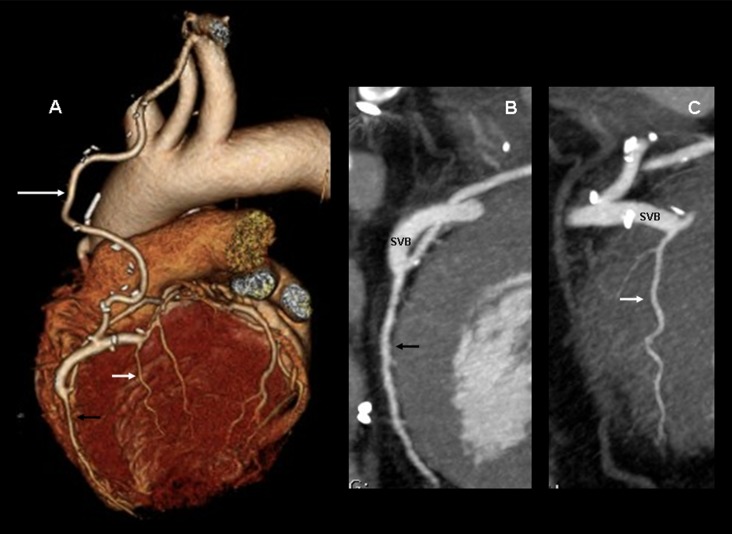
Composite coronary artery bypass graft.256-slice MDCT with prospective ECG-gating, volume rendering (A) and curve reformat (B, C) of a 56-yo man with a composite internal mammary artery with saphenous vein bridge graft (IMA-SVB). The IMA-SVB graft redistributes the flow of the IMA (long white arrow) to the left anterior descending artery (LAD) (black arrow) and to the first diagonal artery (D1) (short white arrow). Distal graft anastomoses on LAD and D1 are well seen. The scores for image quality in all graft segments were 5 (excellent), for both 2 independent observers. SVB: saphenous vein bridge.